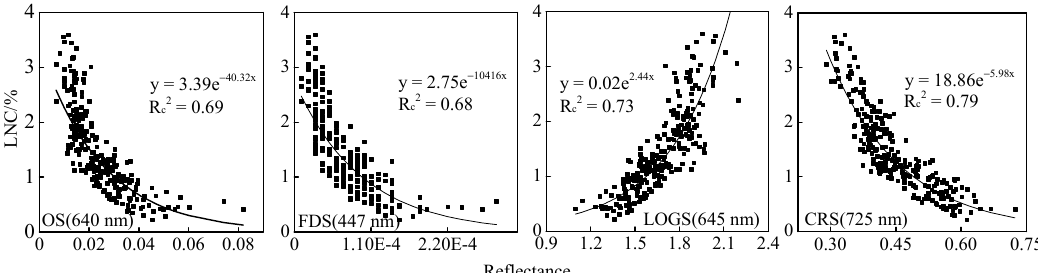
Figure 3. Leaf nitrogen concentration prediction models based on sensitive band reflectance. The solid line represents the exponential fitting.